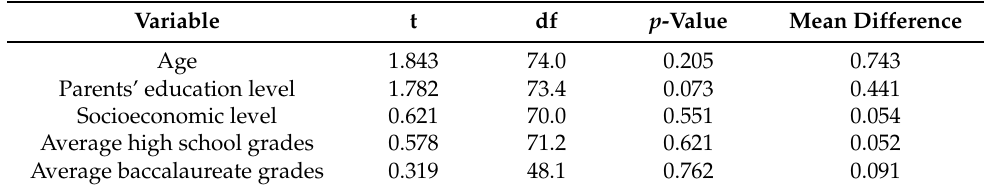
Table 2. Results of the t-test for equality of means (demographics variables).